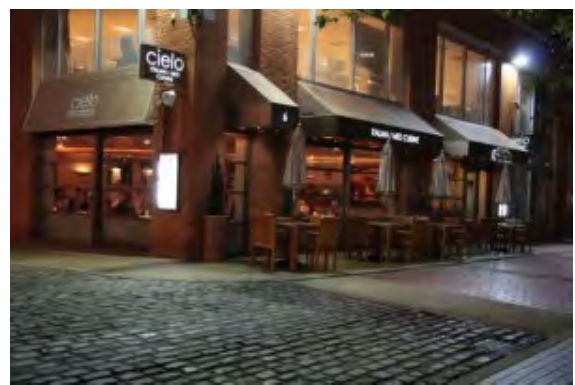
Figure 7. (intimate spaces of the city Birmingham)